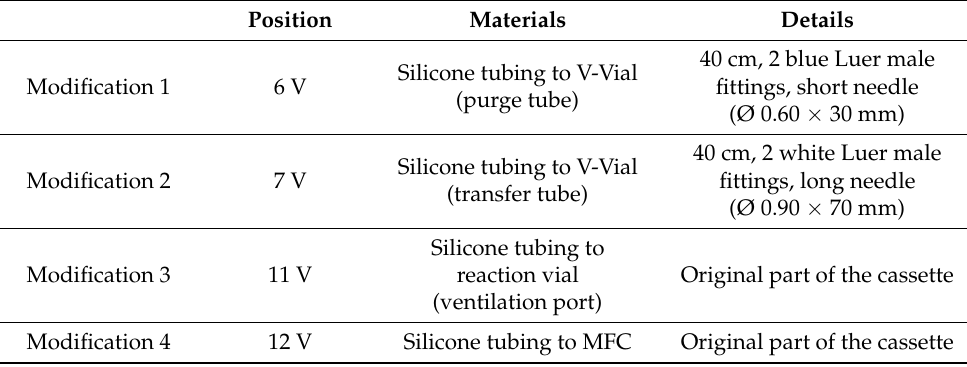
Table 3. Summary of modifications of the 68 Ga-. V = Vertical